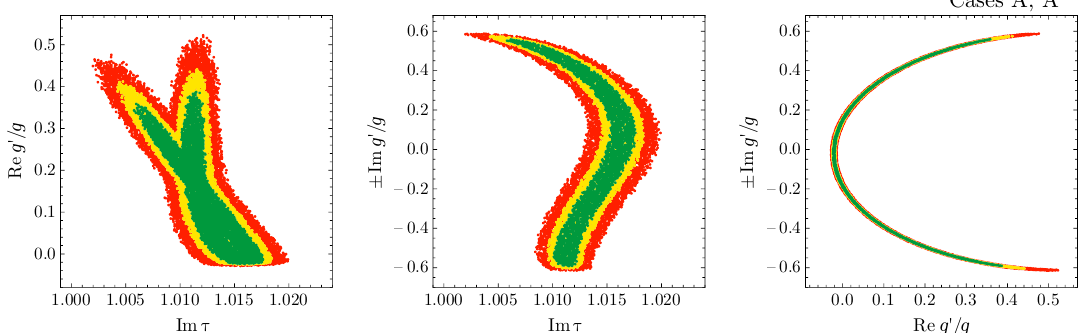
Figure 4. Correlations between the parameters Im (cid:28) , Re g 0 =g and Im g 0 =g in cases A and A (cid:3) , which refer to ( k (cid:3) ; k g ) = (0 ; 2) and to a certain region in the (cid:28) plane (see (cid:12)gure 1). The plus (minus) signs refer to the case without (with) an